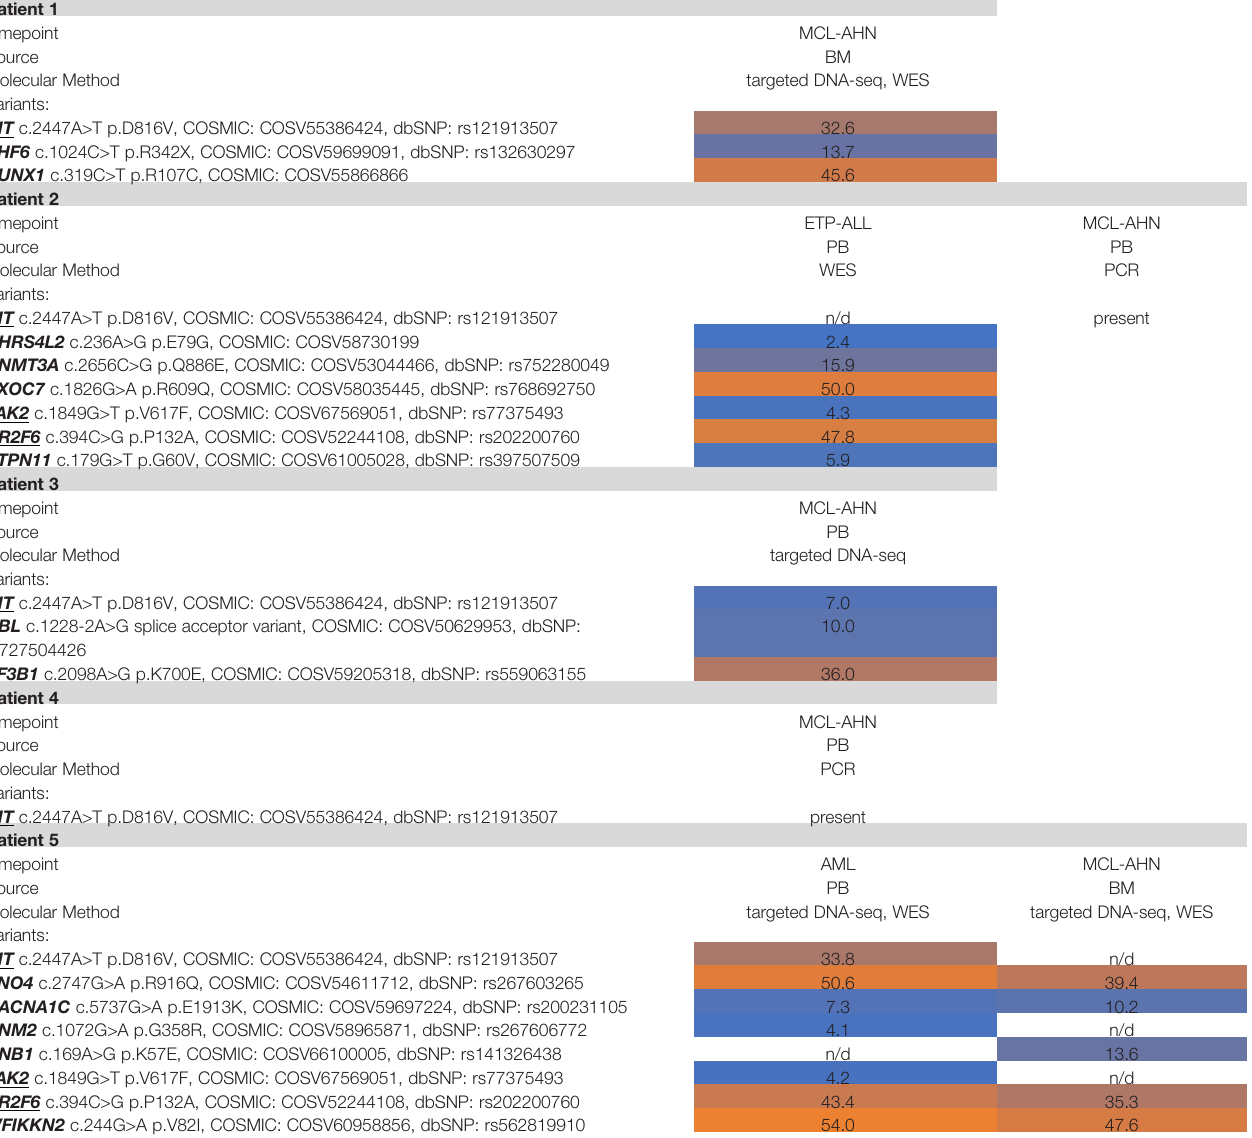
TABLE 2 | Molecular pro fi ling results. Patient 1 Timepoint MCL-AHN